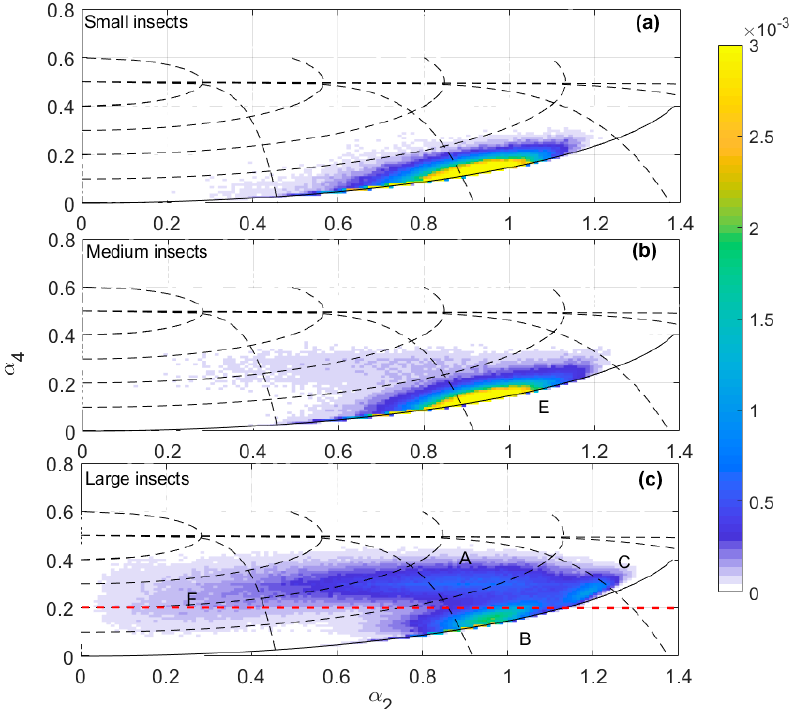
Figure 2. Distribution of the two shape parameters on the ( α 2 , α 4 ) plane for the full 14-year dataset. ( a ) Small insects ( a 0 range -23 to -13 dBsc and f w 21–50 Hz; N (number of insects in the cluster: 331610), ( b ) medium insects ( a 0 range − 13 to − 3 dBsc and f w 21–50 Hz; N: 574232) and ( c ) large insects ( a 0 range − 3 to 7 dBsc and f w 21–50 Hz; N: 989080). Solid and dashed black lines as in Figure 1. Dashed red line as α 4 = 0.2. The color scale indicates the probability density. A, B, C, F are used to denote the clusters for large insects and E for medium insects. Class D (not shown) is a subset of class B. Remote Sens. 2020 , 12 , 673